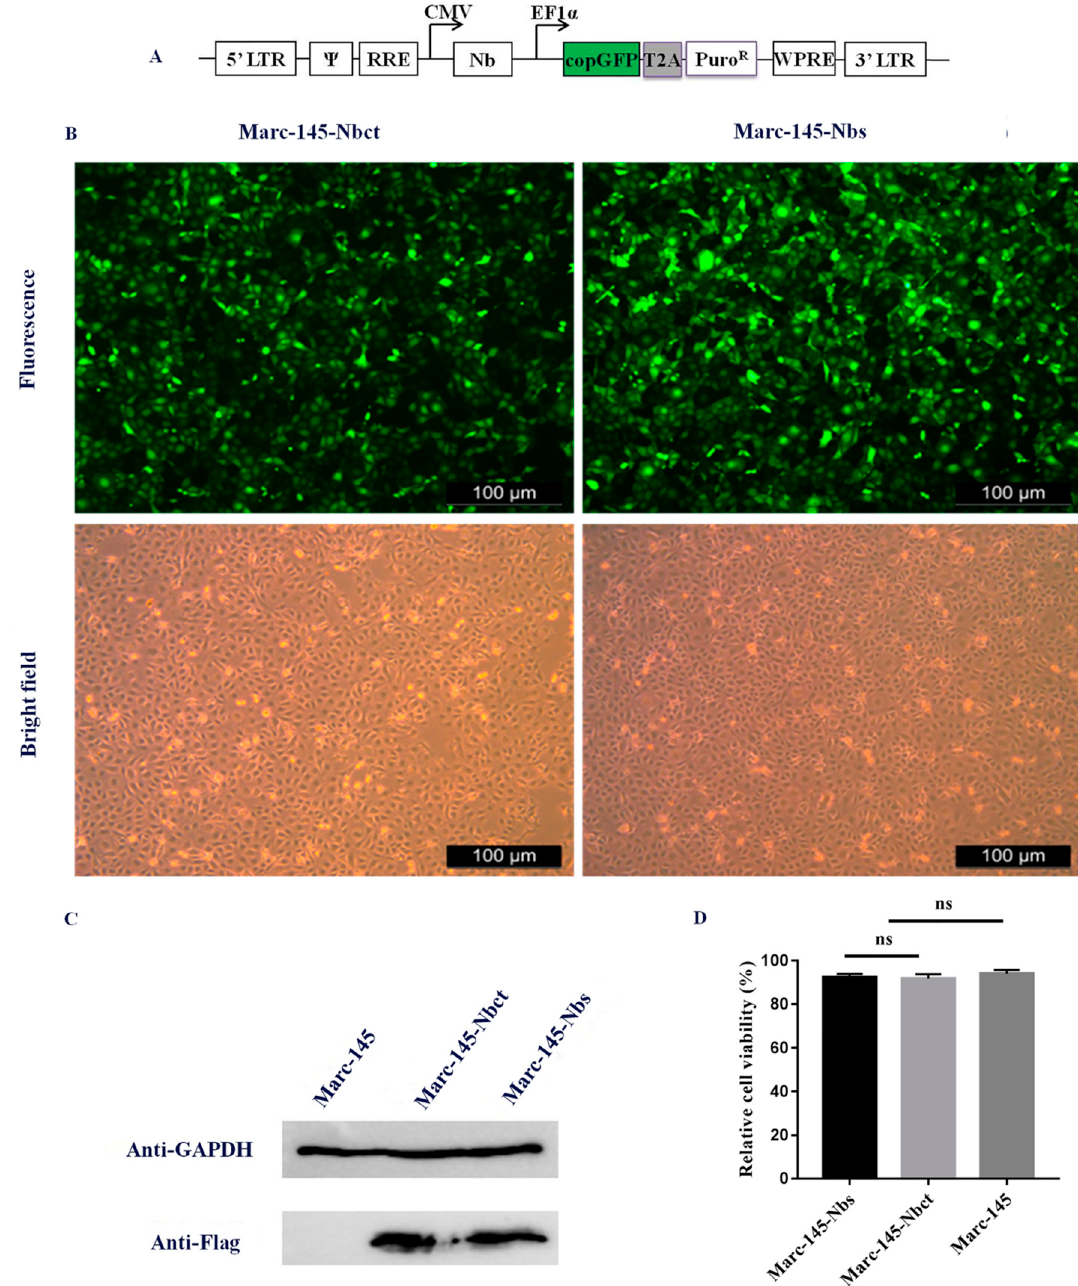
Figure 1. Marc-145 cells stably expressing nanobodies. ( A ) Schematic diagram of lentivirus construct for delivery of nanobodies into cells. CMV: human cytomegalovirus promoter, Nb: nanobody encoding cDNA fragments, EF1 α : human elongation factor 1 α promoter, copGFP: copepod green fluorescent protein (copGFP), T2A: a self-cleaving 2A peptide derived from a virus of the insect Thosea asigna, Puro R : puromycin-resistant marker. ( B ) Cell lines were imaged using fluorescent microscopy (magnification, 100×). ( C ) Expression of nanobody was also detected by Western blot using anti-Flag monoclonal antibody. ( D ) Cell viability assay was performed using MTT assay according to the manufacture’s instruction ( ns, not significant, P >0.05).